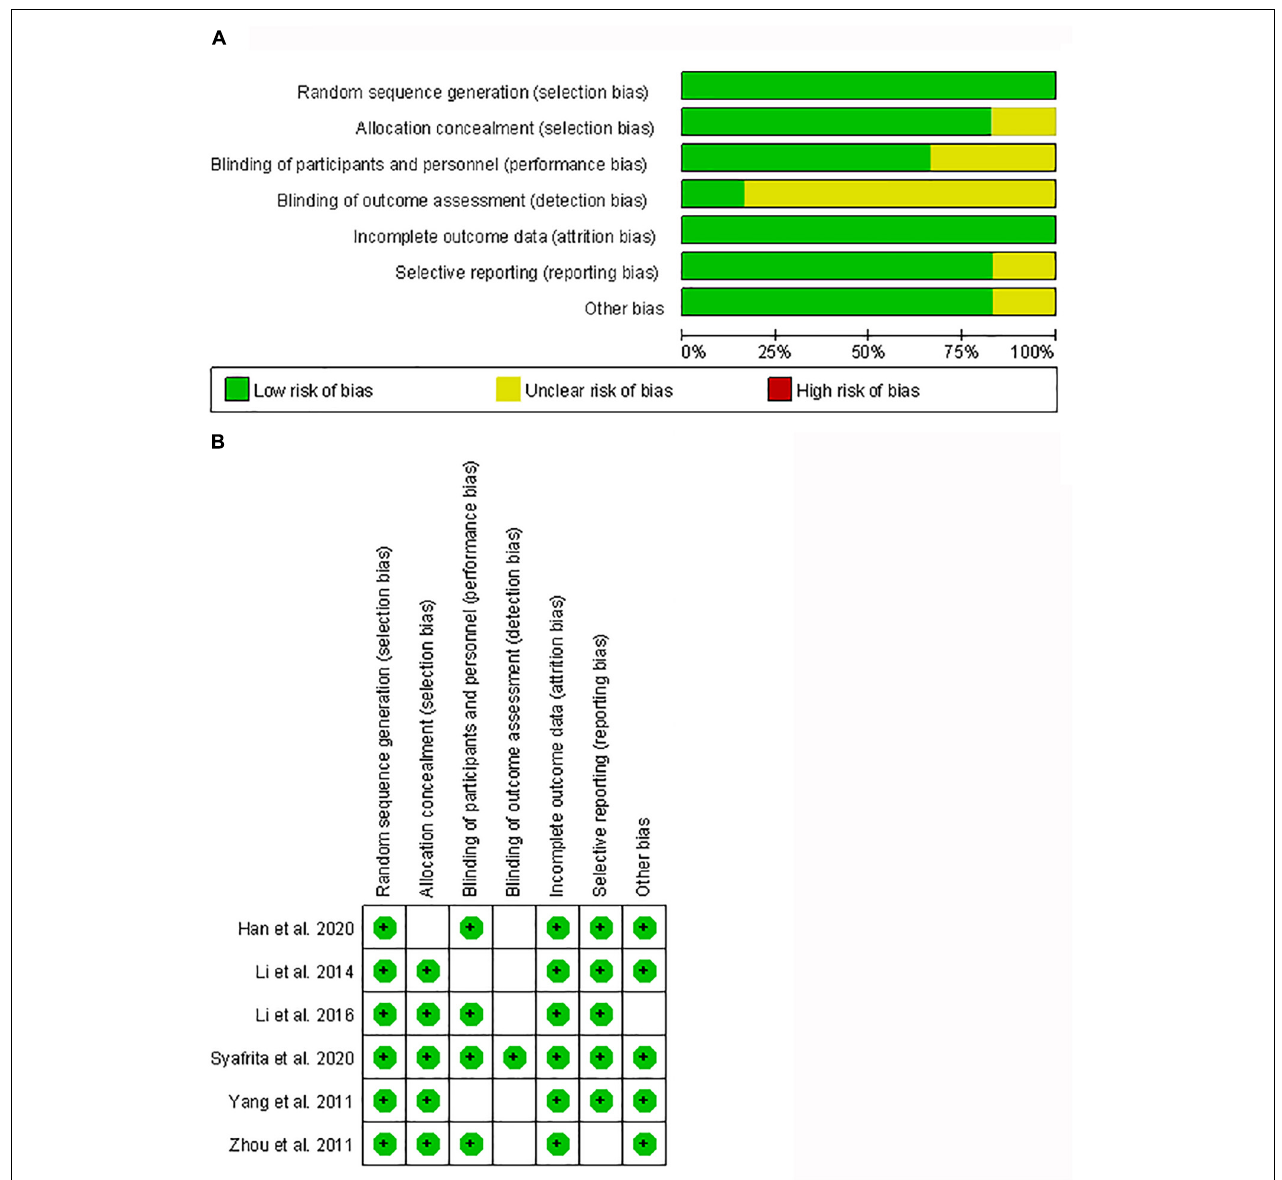
FIGURE 3 | Risk of bias graph (A) and risk of bias summary (B)